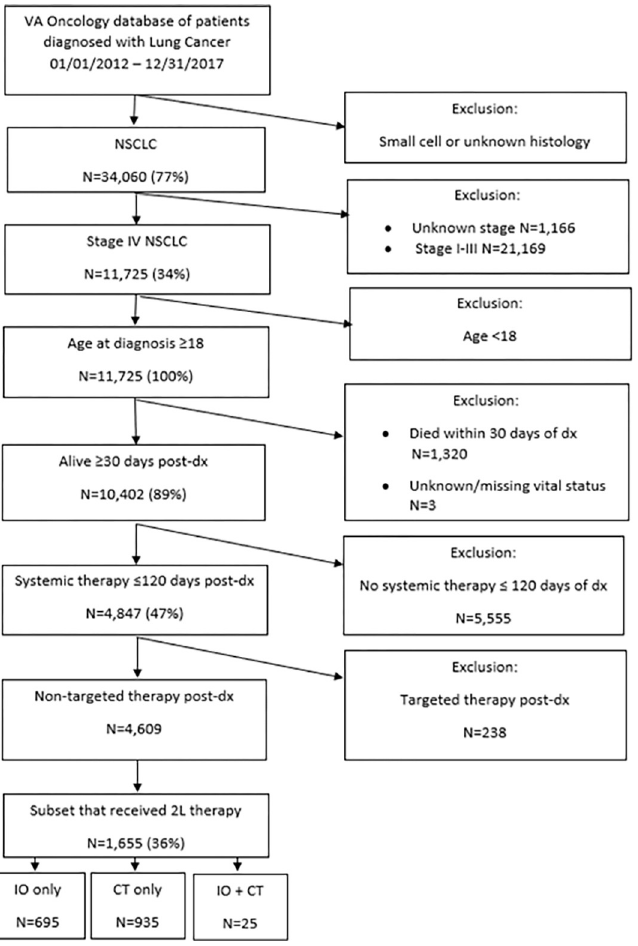
Fig 1. Patient selection flowchart. 2L: second-line; CT: chemotherapy; dx: diagnosis; IO: immunotherapy; NSCLC: non-small cell lung cancer; VA: Veterans Affairs.